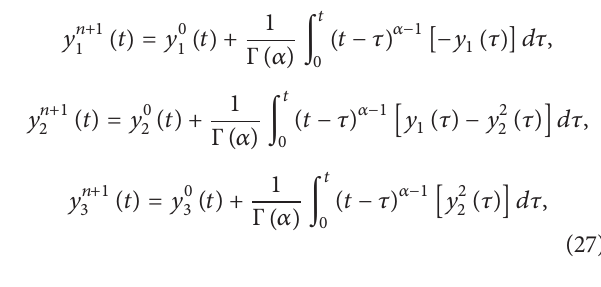
( 𝑥(𝑡) = 𝑒 𝑡 sin (𝑡) , 𝑦(𝑡) = 𝑒 𝑡 cos (𝑡) ). One can see that